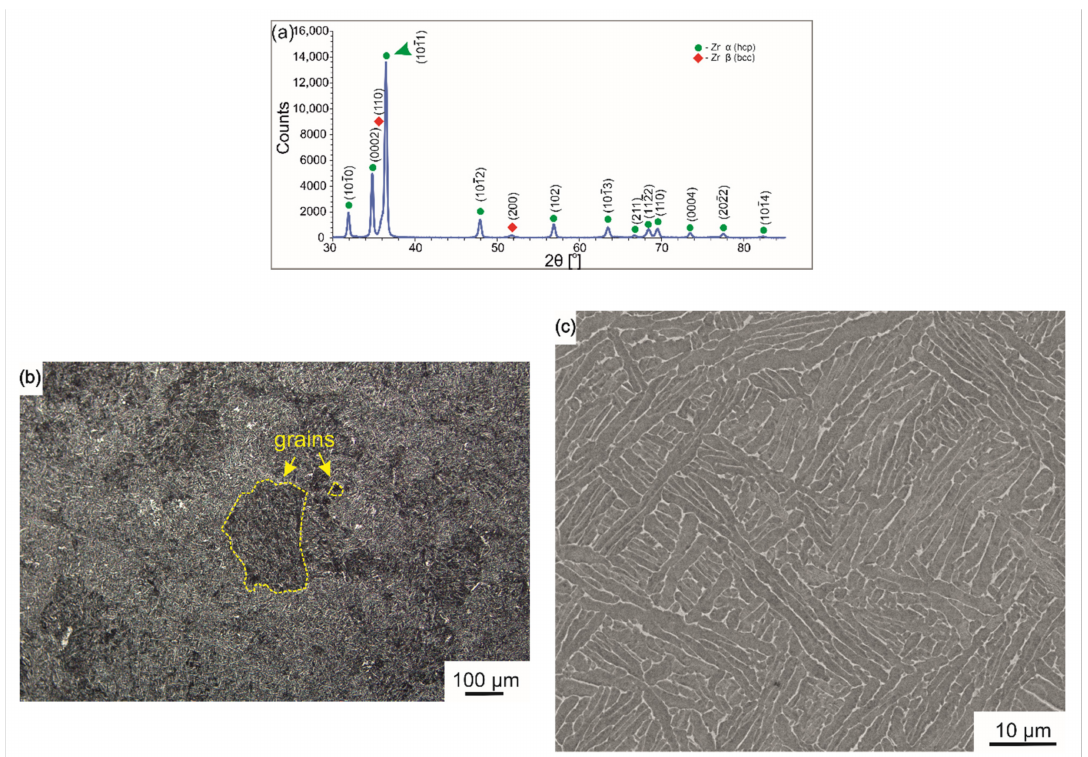
Figure 2. XRD pattern of Zr-2.5Nb alloy ( a ) and microstructure of the cross-section of the bar observed using LM ( b ) and SEM ( c